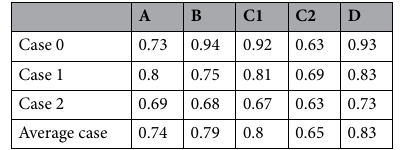
Table 10. 1-D CNN with attention model’s AUC results.